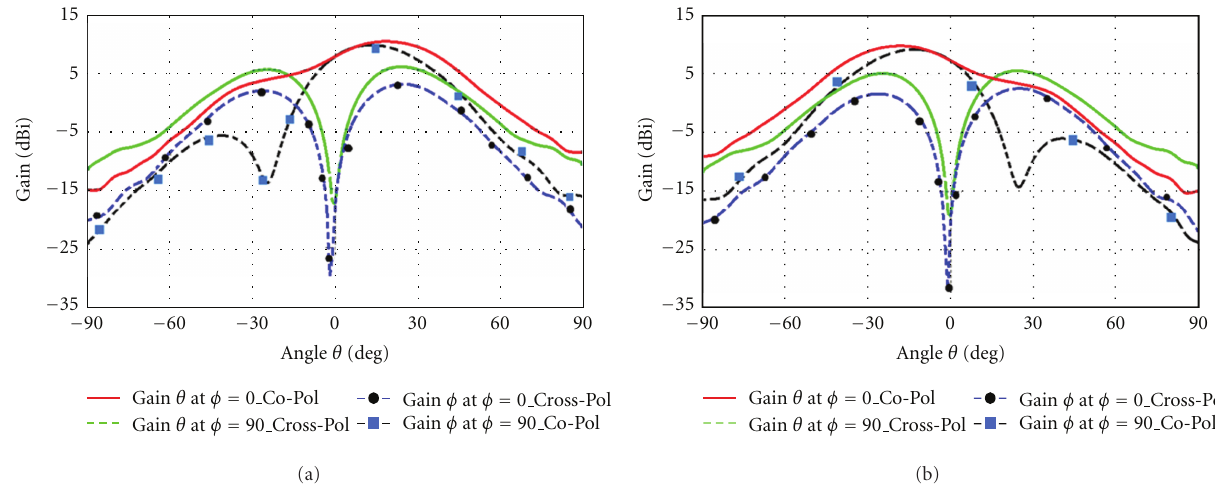
Figure 3: Gain radiation patterns of the triple-mode feedhorn with mode combination of TE 11 (20%) + TM 01 (40%) + TE 21 (40%) at 7.73GHz for (a) +90 ◦ fixed phase, and (b) − 90 ◦ fixed phase.